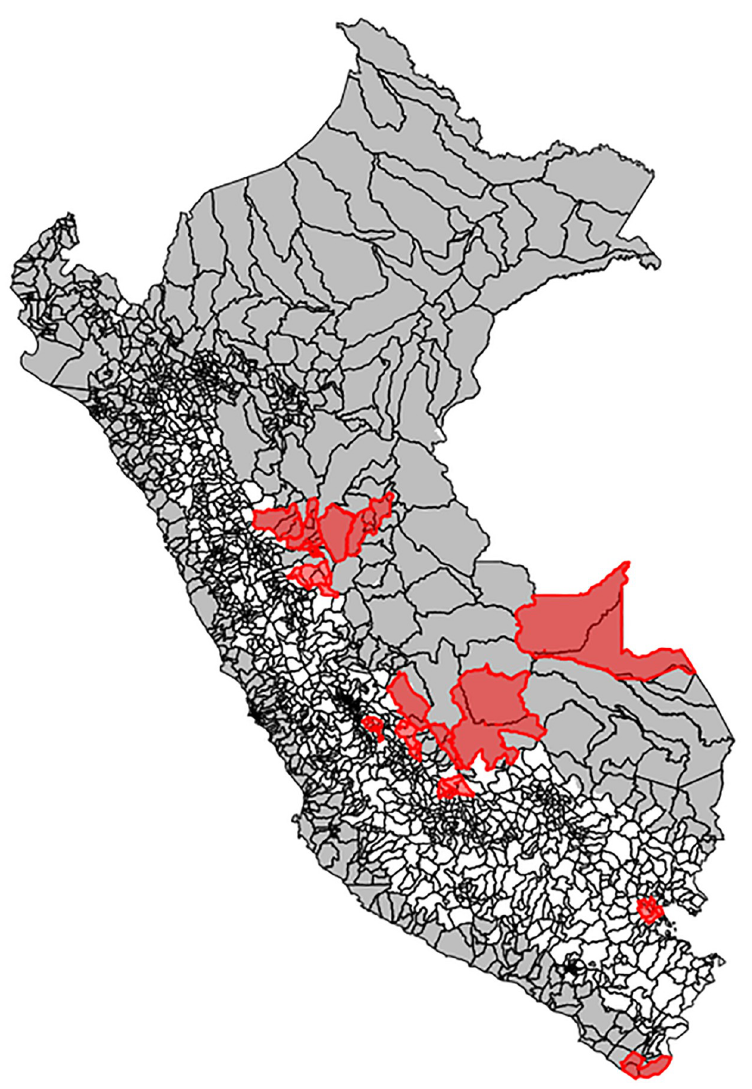
Fig 1. Study districts across Peru (grey). Higher elevation districts (white) excluded from analyses. Merged districts (red) were created by collapsing districts formed during the study period with their parent district(s). Base map source: GEOSS Information Exchange Data Hub,